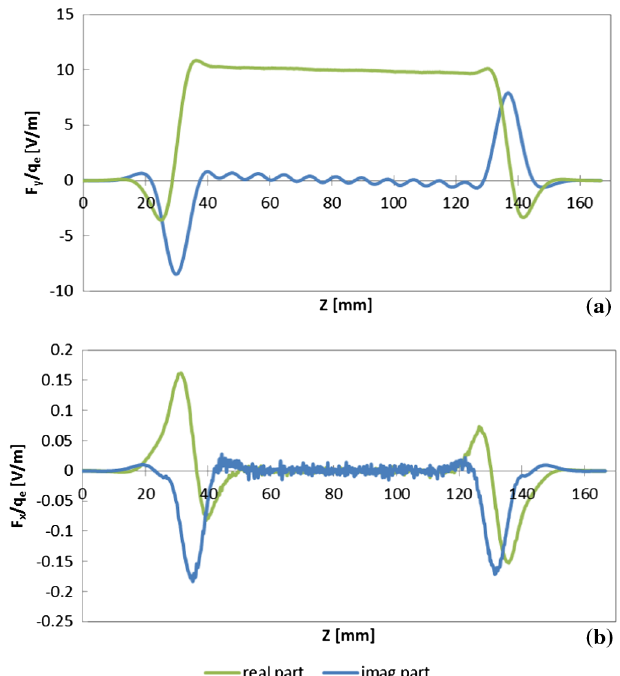
FIG. 21. (a) Horizontal and (b) vertical kicks for the TE coupled cavity for V